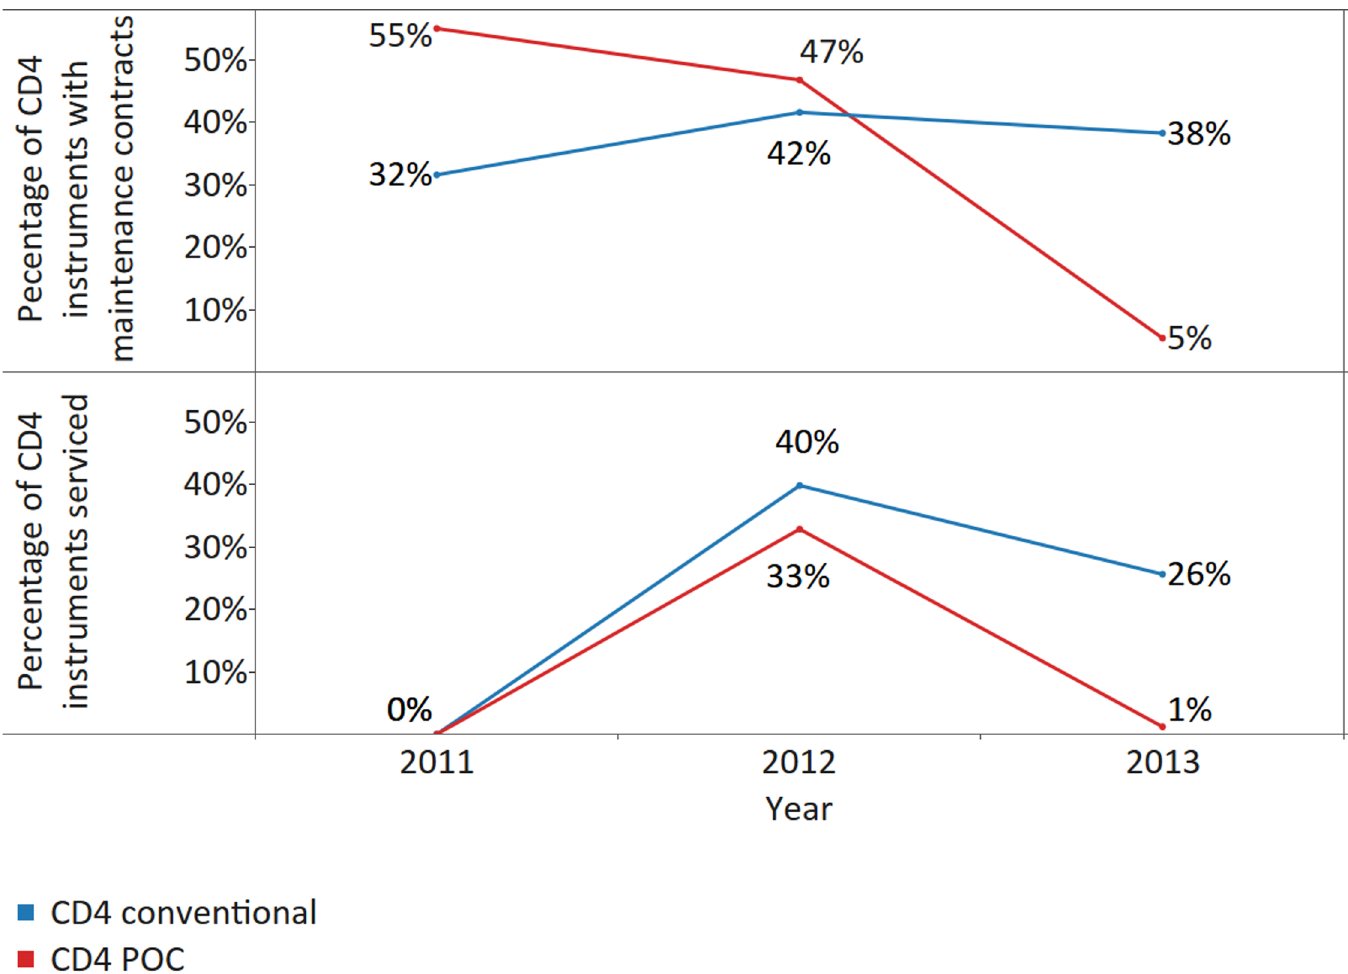
Fig 7. Percentage of CD4 instruments with maintenance contracts (upper panel) and/or serviced (lower panel) in the survey year, disaggregated by CD4 platform, for all reporting